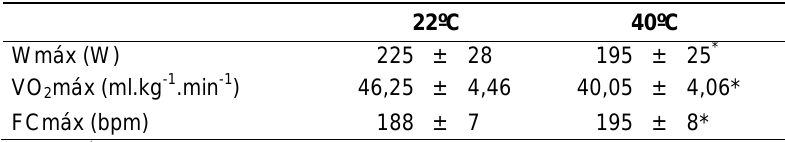
Figura 1. Concentração sanguínea de lactato durante exercício progressivo a 22ºC e 40ºC. † p<0,05 entre ambientes para uma mesma intensidade de exercício; # p<0,05 quando comparado com o repouso a 40ºC; *p<0,05 quando comparado com o repouso a 22ºC; n=8. Os valores de Wmáx e VO máx foram menores no ambiente quente (p<0,05), enquanto a FCmáx foi 2 maior (p<0,05) neste ambiente (Tabela 1). Tabela 1. Potência máxima (Wmáx), consumo máximo de oxigênio (VO máx), frequência cardíaca máxima 2 (FCmáx) determinados em ambiente temperado (22ºC) e quente